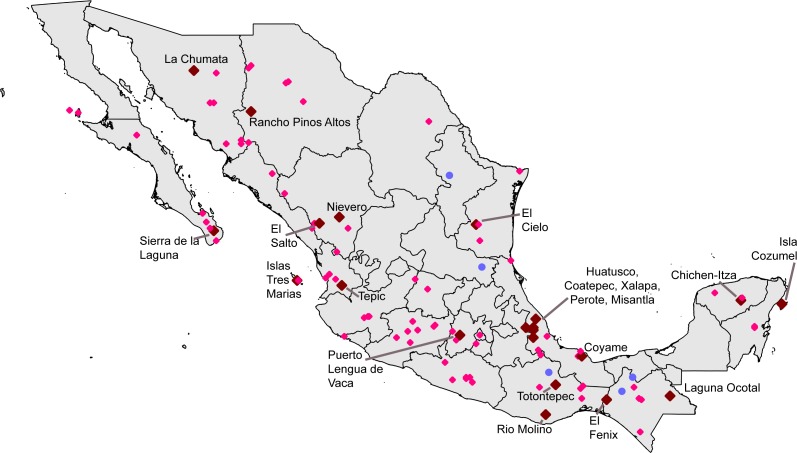
Distribution of single 0.05° grid squares for which >200 records were available and completeness (C) was 0.8 ≤ C < 0.9 (pink) or C ≥ 0.9 (brown).Sites detected in Step 3 (i.e., single sites that are relatively complete, but that were not georeferenced prior to this study) are shown in blue (all had 0.8 ≤ C < 0.9).